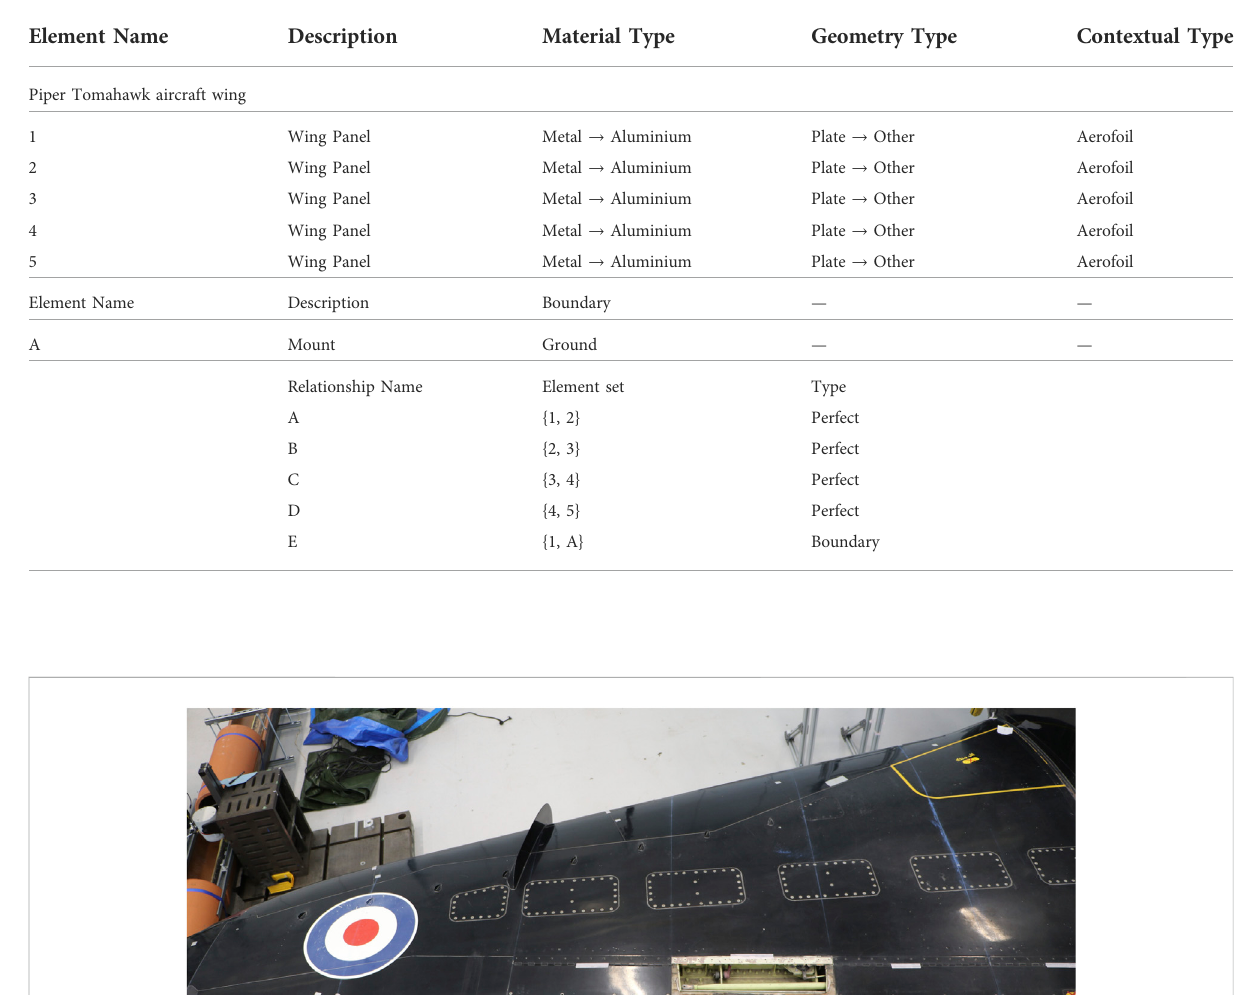
TABLE 9 List of elements and relationship, as well as their properties, for the Piper Tomahawk aircraft wing.